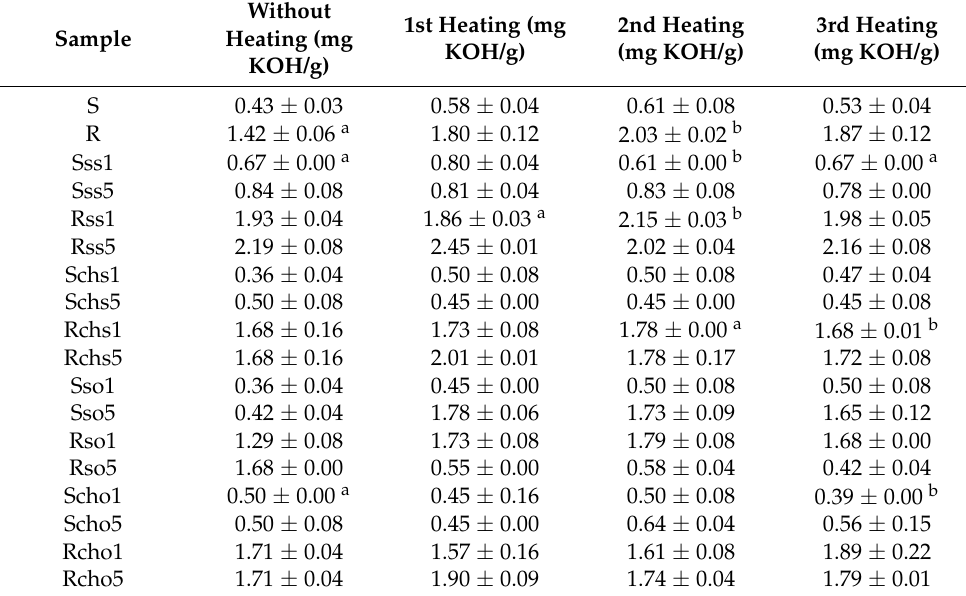
Table 6. Hydrolytic stability of fortified oil samples after repeated cycles of heating.